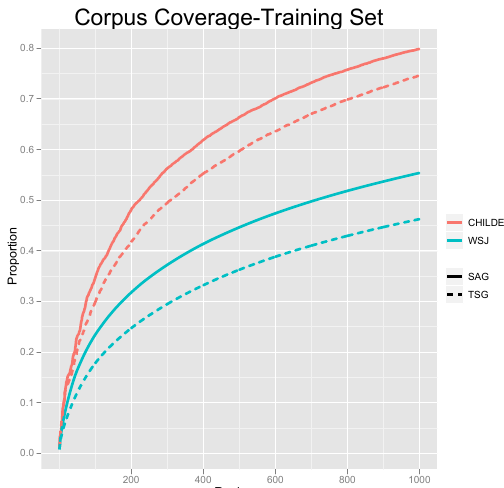
Corpus Coverage-Training Set